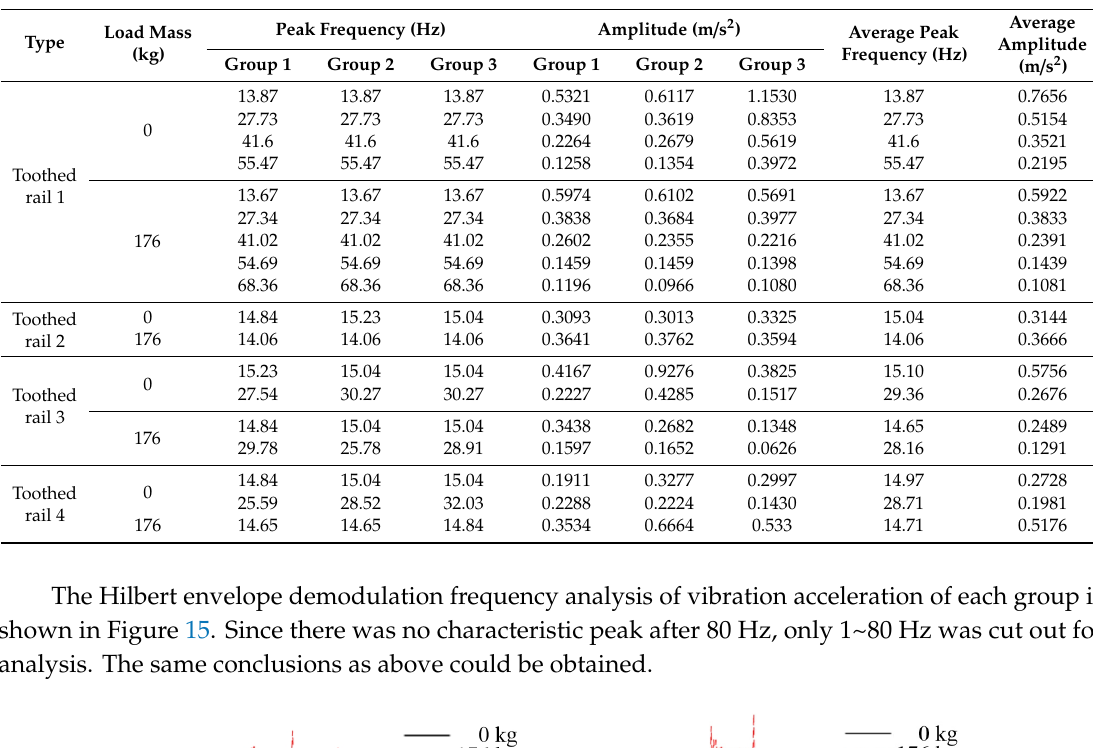
Table 4. Peak amplitude-frequency table of the toothed rails.